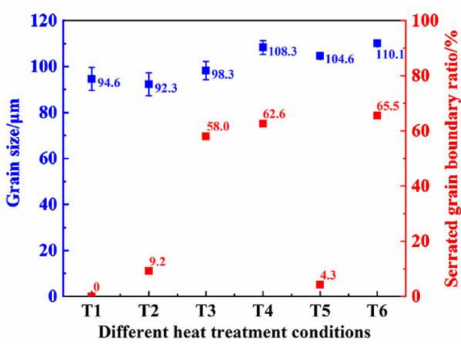
Figure 5. The mean grain size and serrated grain boundary ratio of GH4975 alloy under different heat treatment